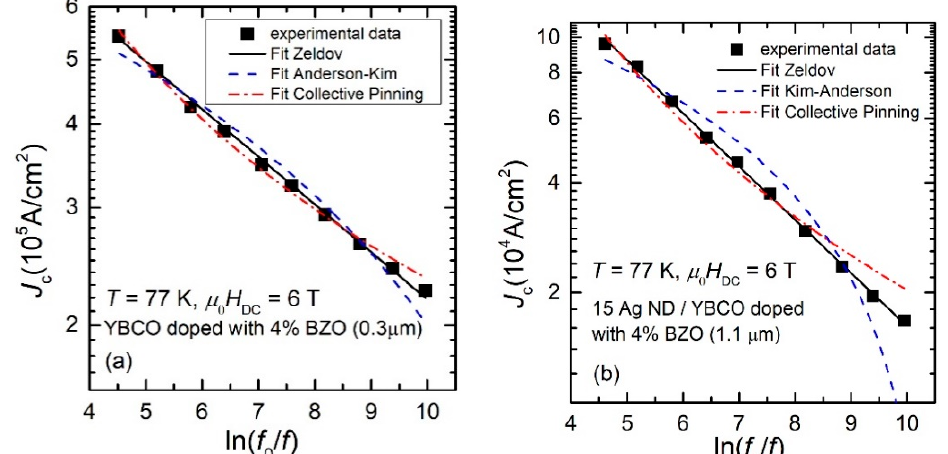
Figure 3. Dependence of the critical current density J c on the frequency of the AC excitation field, at 77 K and in a DC field of 6 T, for a 0.3 µm-thick film of YBCO doped with 4% wt. BZO ( a ) and for a 1.1 µm-thick film of YBCO doped with 4% wt. BZO grown on a STO substrate decorated with Ag nanodots obtained by 15 laser shots on the silver target ( b ). All other details are similar to Figure 2. For all the investigated samples, the experimental J c , in logarithmic scale, decreases linearly with ln ( f 0 / f ). In the following sub-chapter, we will show that such dependence is compatible with the logarithmic dependence of the pinning potential on the probing cur- rent, proposed by Zeldov et al. [22].